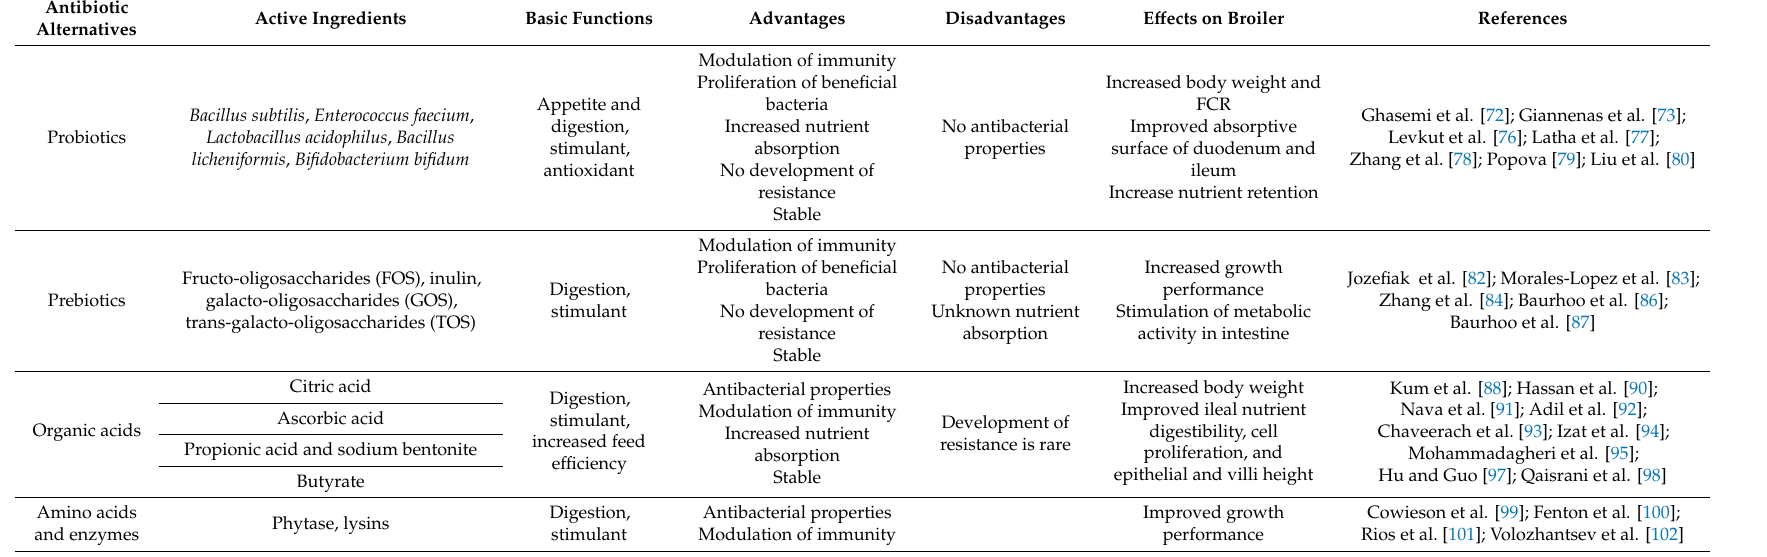
Table 2. Antibiotic alternatives and their functions and e ff ects in broiler production. FCR, feed conversion ratio and BW, body